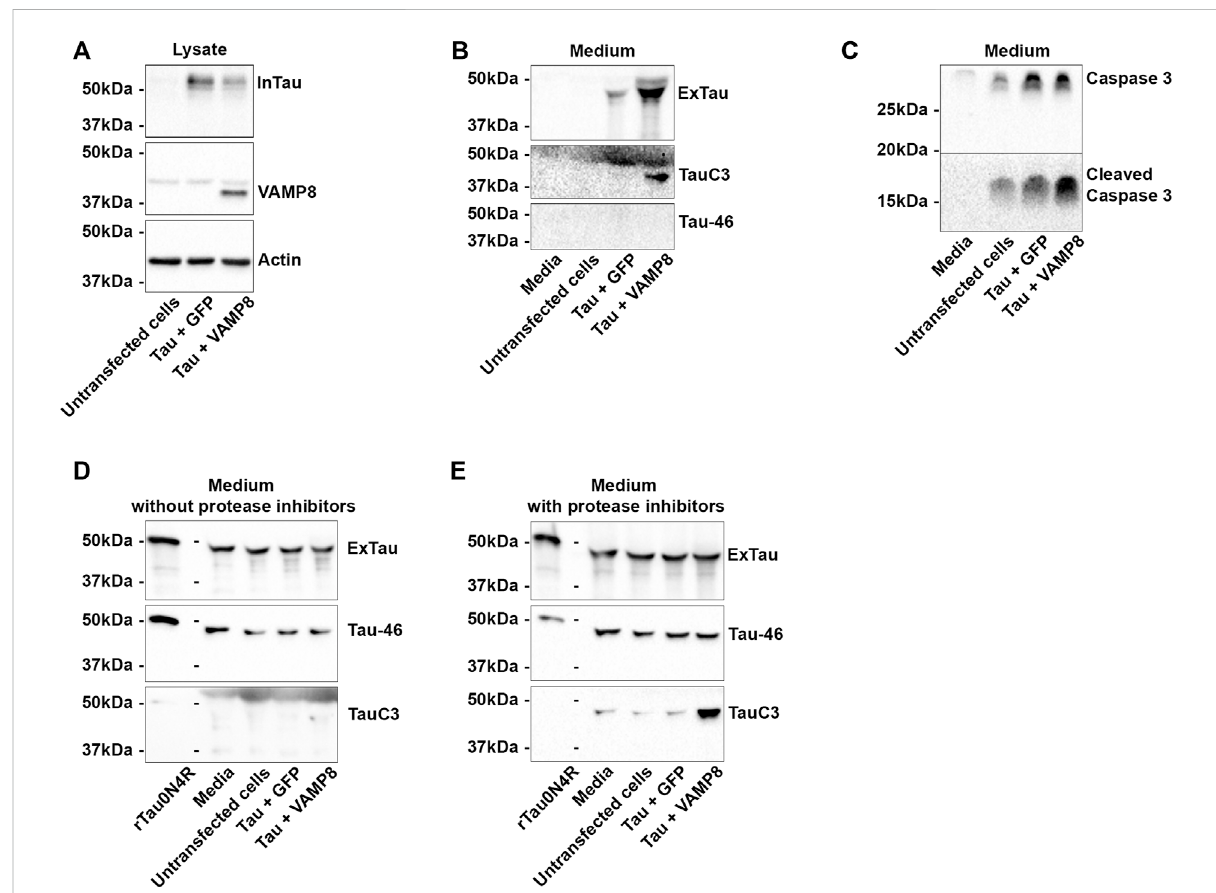
FIGURE 4 Extracellular cleavage of Tau by caspase-3. N2a cells were transfected either with Flag-Tau and GFP-empty or Flag-Tau and GFP-VAMP8 plasmids. Recombinant 0N4R Tau protein (rTau) was added in media after 48 h post transfection. The medium without cells and the medium of untransfected cells were used as controls. (A) Representative Western blot of the cell lysate con fi rming the expression of Tau and VAMP8. (B) Representative Western blot of the medium showing the secretion of Tau and Tau cleaved by caspase-3 (TauC3). The lack of signal with the anti-Tau antibody Tau-46 indicated that Tau was cleaved at the C-terminal. (C) Representative Western blot with anti-caspase-3 and the anti- cleavedcaspase-3antibodiestocon fi rmtheirpresenceinthemediumbeforetheadditionofrTau. (D)